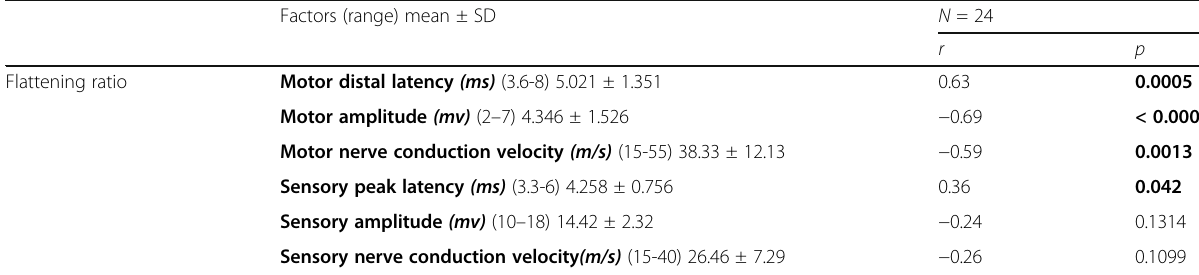
Table 4 Correlation between the flattening ratio and electro-diagnostic study parameters Factors (range) mean ± SD Flattening